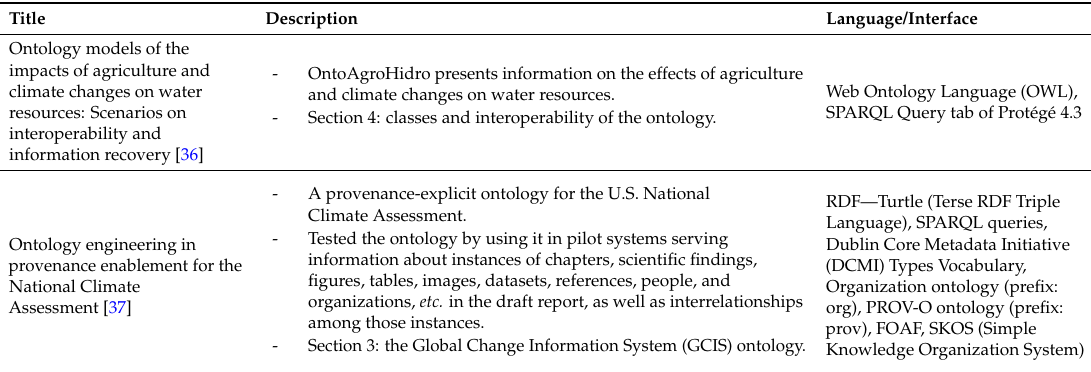
Section 3: the Global Change Information System (GCIS)